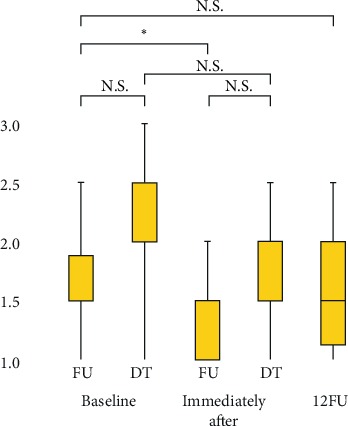
Intelligibility.